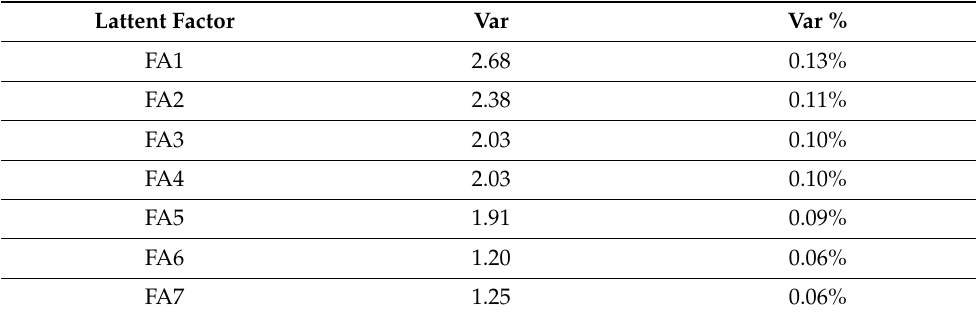
Table 2. Variance explained (Var) and percentage of the total variance explained (Var %) by the factors after rotations. Lattent